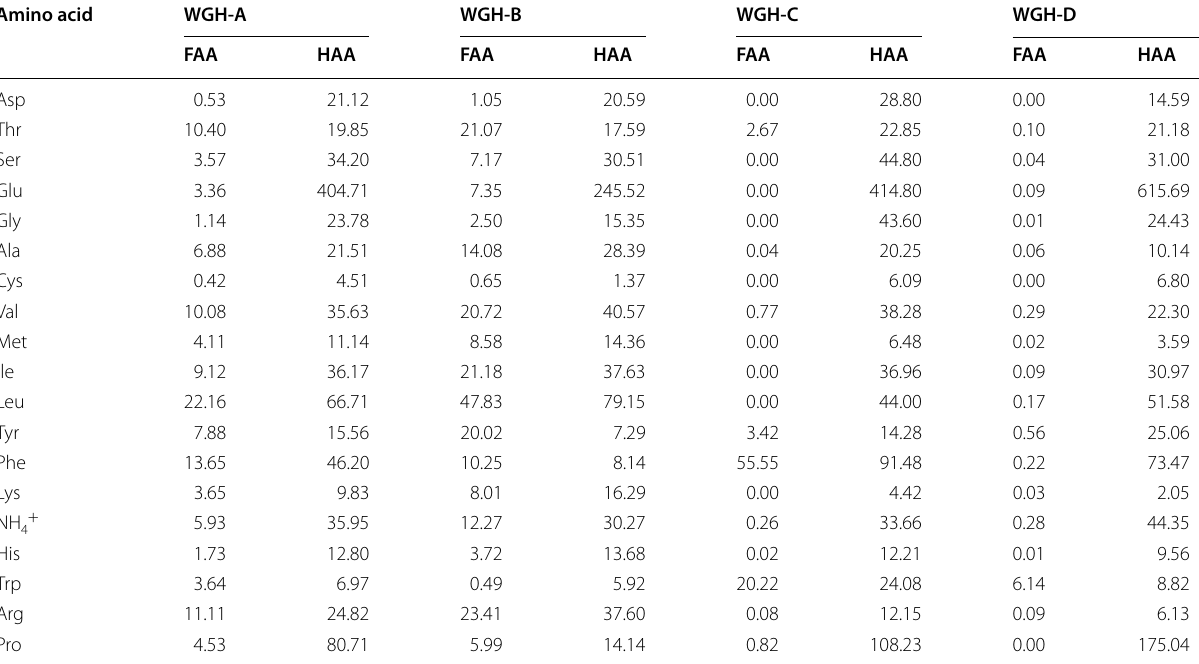
Table 1 Amino acid compositions of WGH-A and WGH-A elution fractions (mg/g) a